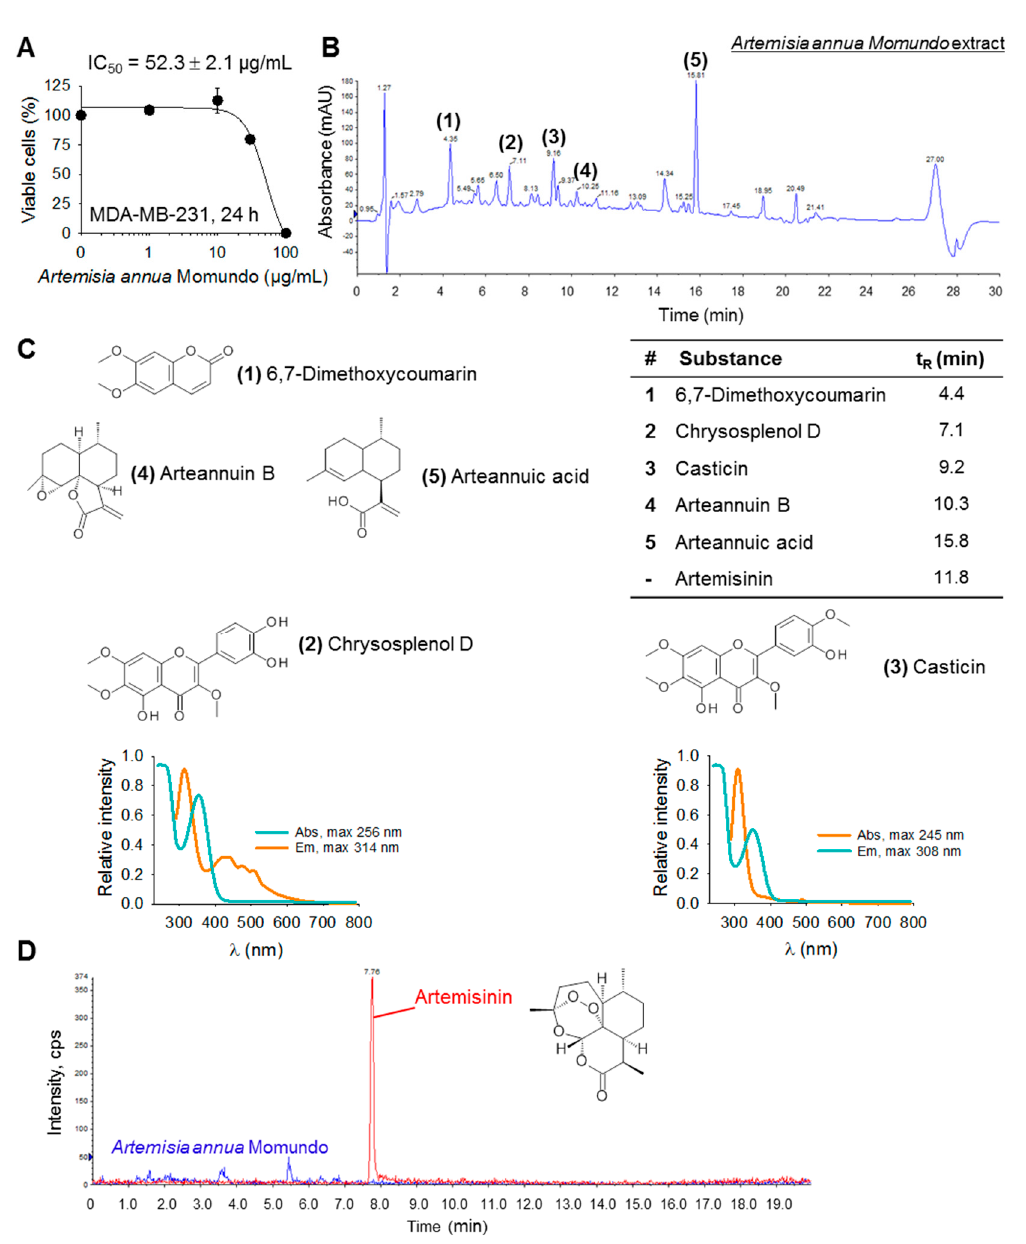
Figure 1. Most abundant compounds of an Artemisia annua dietary supplement. ( A ) Acetonitrile extract of the Momundo Artemisia annua dietary supplement is cytotoxic to MDA-MB-231 breast cancer cells as analyzed by 2,3-bis-(2-methoxy-4-nitro-5-sulfophenyl)-2h-tetrazolium-5-carboxanilide (XTT). ( B ) High-performance liquid chromatography coupled with diode-array and mass spectrometric detection (HPLC-DAD) fingerprint of the acetonitrile-enriched Artemisia annua Momundo extract. ( C ) The most abundant compounds were identified by comparison of retention times and mass spectra of reference substances or by 1 H and 13 C NMR spectroscopy. UV / Vis spectra of chrysosplenol d and casticin (methanol / water, 1:1) are shown. ( D ) HPLC-MS / MS chromatograms with multiple reaction monitoring (MRM) of artemisinin reference standard solution (red) and the Momundo extract (blue) indicating that the artemisinin concentration in the Momundo extracts is below the limit of detection (LOD = 0.2 ng / mg extract, recovery 94.8%). 2.2. Chrysosplenol D and Casticin Selectively Inhibit the Viability of Several Cancer Cell Lines Chrysosplenol D and casticin inhibited the viability of the MDA-MB-231 TNBC cells after 48 h with IC 50 values of 11.6 and 19.5 µM, respectively. The most sensitive cell line towards chrysosplenol D and casticin was the non-small-cell lung carcinoma (NSCLC) cell line A549 and the most resistant